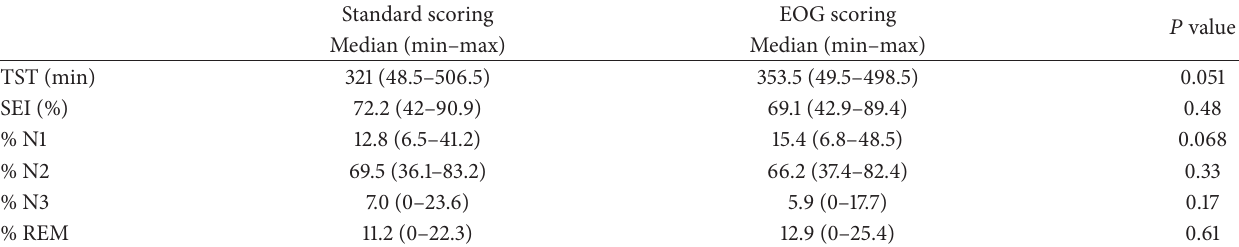
Table 1: Sleep stage parameters of the PSG group with the two different scoring systems.